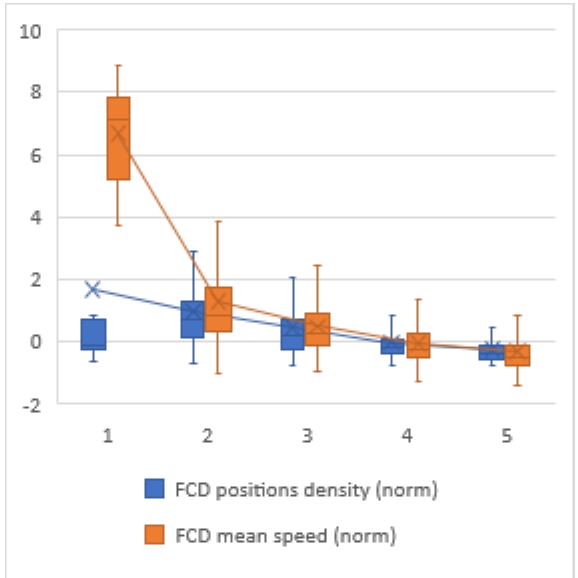
Figure 2 – Normalised FCD values for density and mean speed (Y axes) plotted against BDTRE functional classes (X axes). “X” represent mean values, the middle line of the box represents the median, the bottom line of the box represents the 1st quartile, the top line of the box represents the 3rd quartile, the whiskers (vertical lines) extend from the ends of the box to the minimum value and maximum